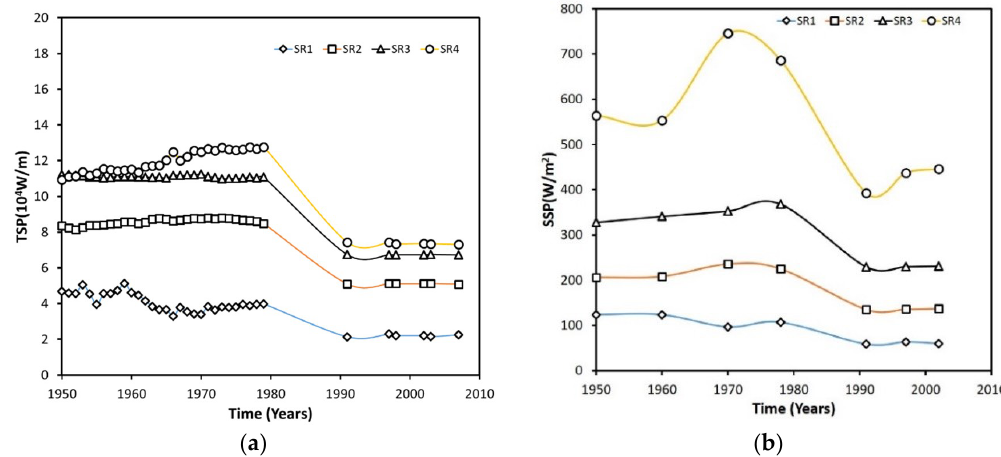
Figure 10. Spatial and temporal variations in ( a ) total stream power (TSP) and ( b ) specific stream power (SSP).